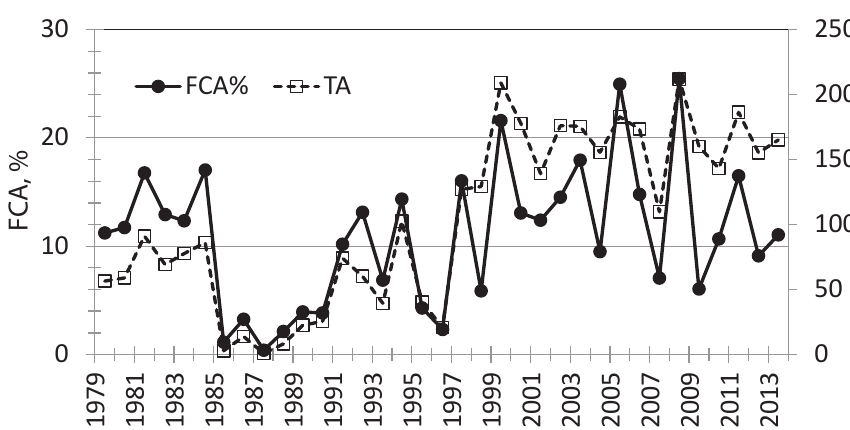
Figure 12. Mean FCA (%) for the July–August period in the Baltic Sea (solid black circle, left axis) and the corresponding total area (TA, km 2 ; rectangle, dashed line) of the accumulations (corresponding numerical data in Table